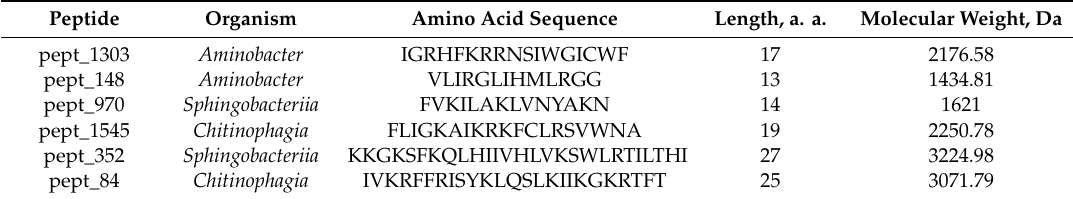
Table 1. The list of antimicrobial peptides (AMPs) from the H. medicinalis